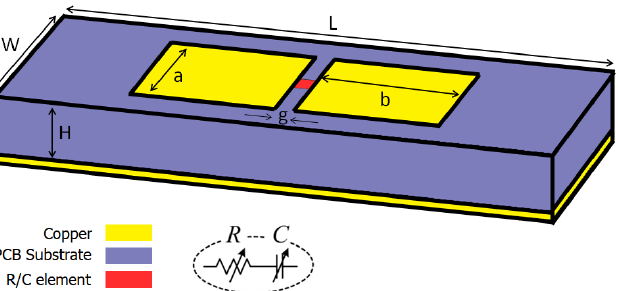
Figure 3. Schematic of the unit cell for the proposed MSF. The dimensions are L = 30 mm, W = 12 mm, H = 3.18 mm, a = 7.85 mm, b = 7.50 mm and g = 1 mm.